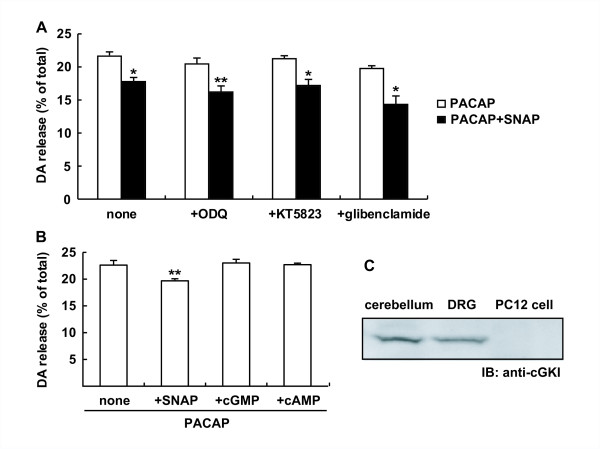
No mediation of the cGMP/cGK pathway in inhibition of dopamine release by SNAP. A. Effect of inhibitors of the NO/cGMP/cGK pathway on attenuation of dopamine release by SNAP. PC12 cells (4 × 105 cells/well) were stimulated for 5 min with 10 nM PACAP without (open columns) or with (closed columns) 100 μM SNAP in the presence of 300 nM ODQ, 1 μM KT5823 or 1 μM glibenclamide. B. Effect of cGMP and cAMP on dopamine release stimulated by PACAP. PC12 cells were stimulated for 5 min with 10 nM PACAP in the presence of 100 μM SNAP, 100 μM 8-Br-cGMP or 100 μM 8-Br-cAMP. Dopamine was measured by HPLC, and dopamine (DA) released into the medium (mean ± SD, n = 3) was expressed as a percentage of total dopamine in PC12 cells as described in the legend for Figure 2. *P < 0.05; **P < 0.01 vs. PACAP alone. C. Expression of cGKI in tissues and PC12 cells. Aliquots (100 μg/lane) of supernatants after centrifugation of homogenates of tissues and PC12 cells at 10,000 × g for 30 min were applied to 7.5% SDS-PAGE and immunoblotted with anti-cGKI antibody.